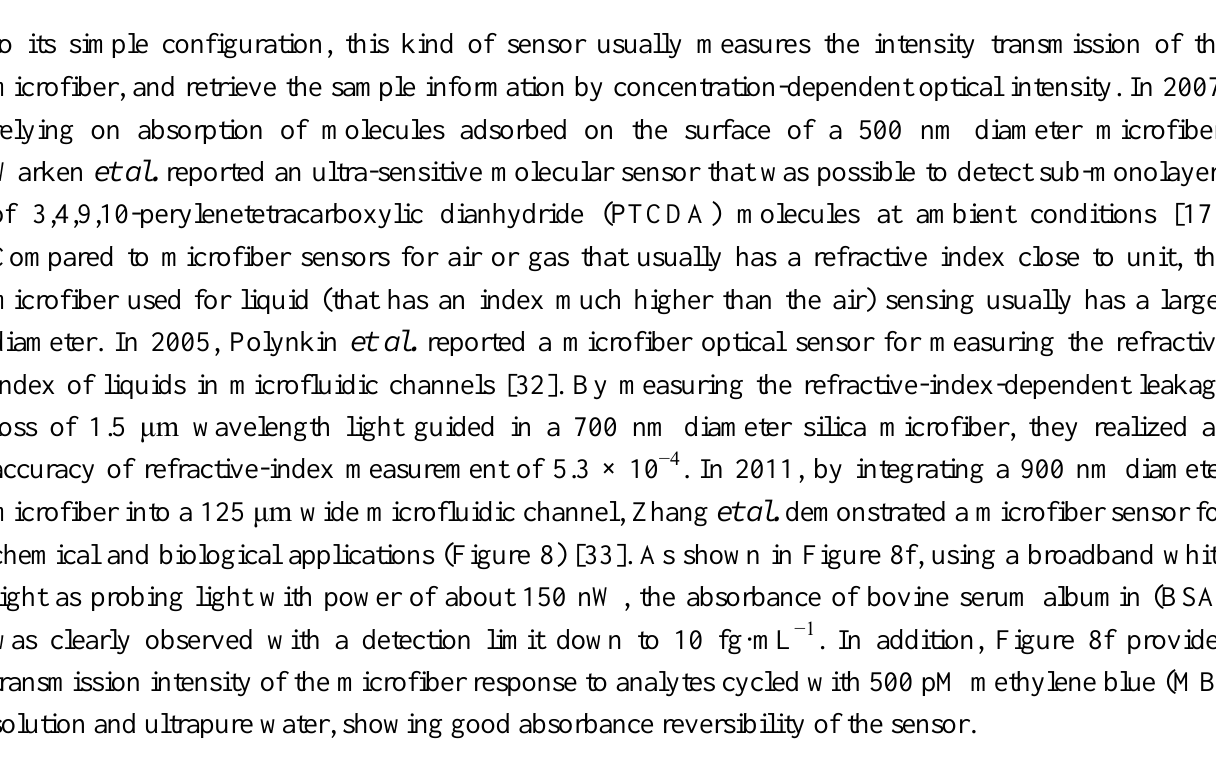
Figure 8. Microfiber absorption sensor [33]. ( a ) Biconical tapered fiber with a 900 nm diameter waist (microfiber). Scale bars: 125 μm; ( b , c ) Cartoon and optical micrographs of microfluidic chip based microfiber sensor fabrication procedures; ( d ) Optical micrograph of a 1.5 μm diameter microfiber guiding a laser with a wavelength of 473 nm embedded in a microchannel; ( e ) Optical micrograph of the fluorescence excited by evanescent field outside a 1.5 μm diameter microfiber. Scale bars: 125 μm; ( f ) Transmission spectra of different MB concentrations for the sensor with a 900 nm diameter microfiber. Inset: diameters of 900 nm and 1.5 mm, respectively; ( g ) Cycling measurement with 500 pM